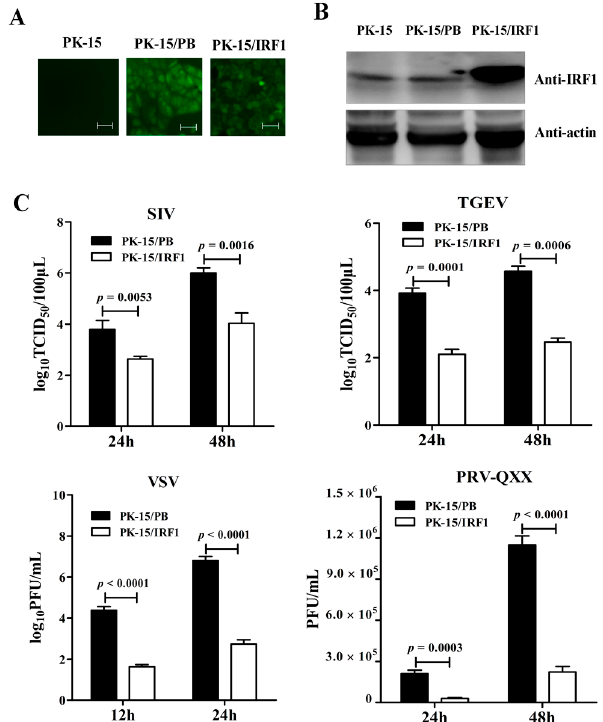
Figure 2. Overexpression of poIRF1 potently inhibits virus replication. ( A ) PK-15 cells stably expressing poIRF1 were established by PB transposon systems. After puromycin treatment, the single puromycin-resistant and GFP-positive cell clones, designated as PK-15/IRF1 and PK-15/PB, were captured on a fluorescence microscope; scale bar, 100 µm; ( B ) Detection of poIRF1 protein by Western blot. Protein lysates from PK-15, PK-15/PB and PK-15/IRF1 were denatured in SDS sample buffer. Denatured lysates were analyzed by SDS-PAGE followed by Western blot using antibodies detecting poIRF1, as indicated. β -actin was used as a loading control; ( C ) The impact of poIRF1 overexpression on viral replication. PK-15 cells stably expressing poIRF1 or with vector alone were incubated with indicated viruses for 24 h and 48 h before supernatants were harvested. The viral titers in supernatants were measured with TCID 50 assay or plaque assay.